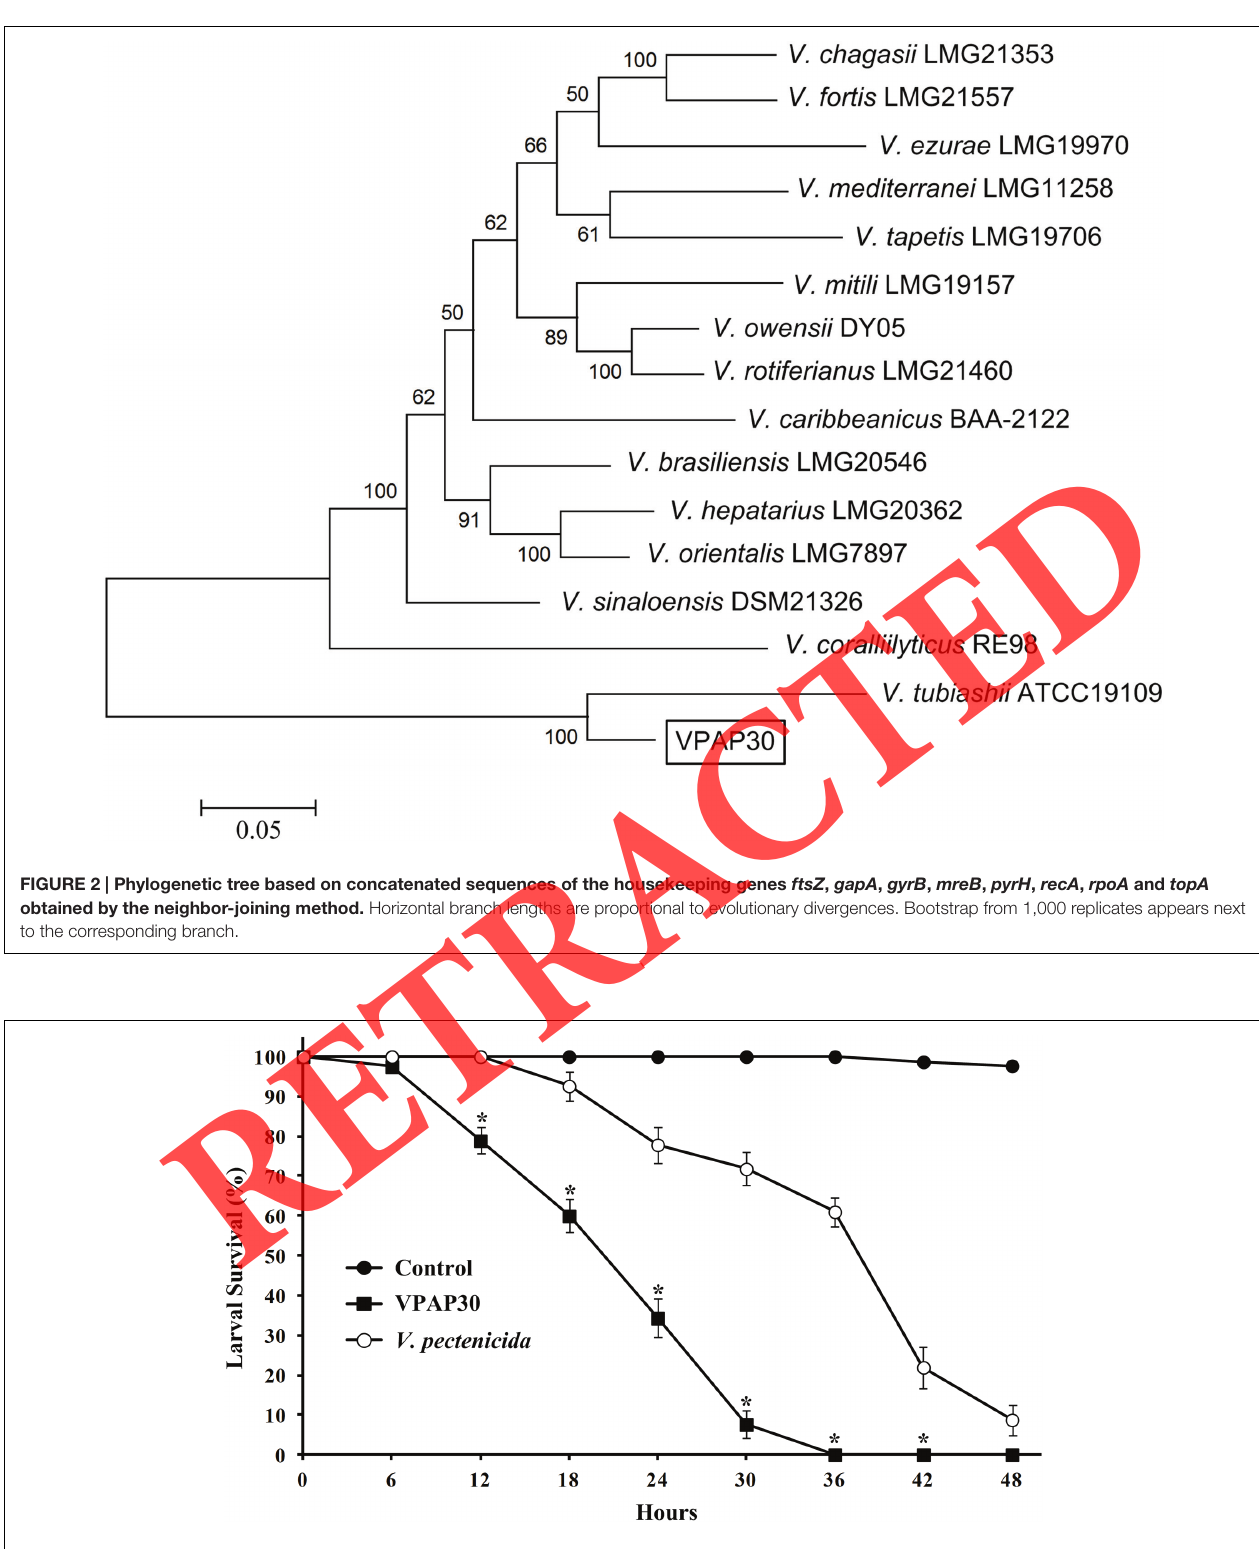
FIGURE 3 | Survival of 10-day-old scallop larvae not challenged (control) and challenged with 1 × 10 5 CFU mL − 1 of Vibrio tubiashii VPAP30 and Vibrio pectenicida A365. Values are a mean ( ± SD) of three replicates. Asterisks indicate significant differences.